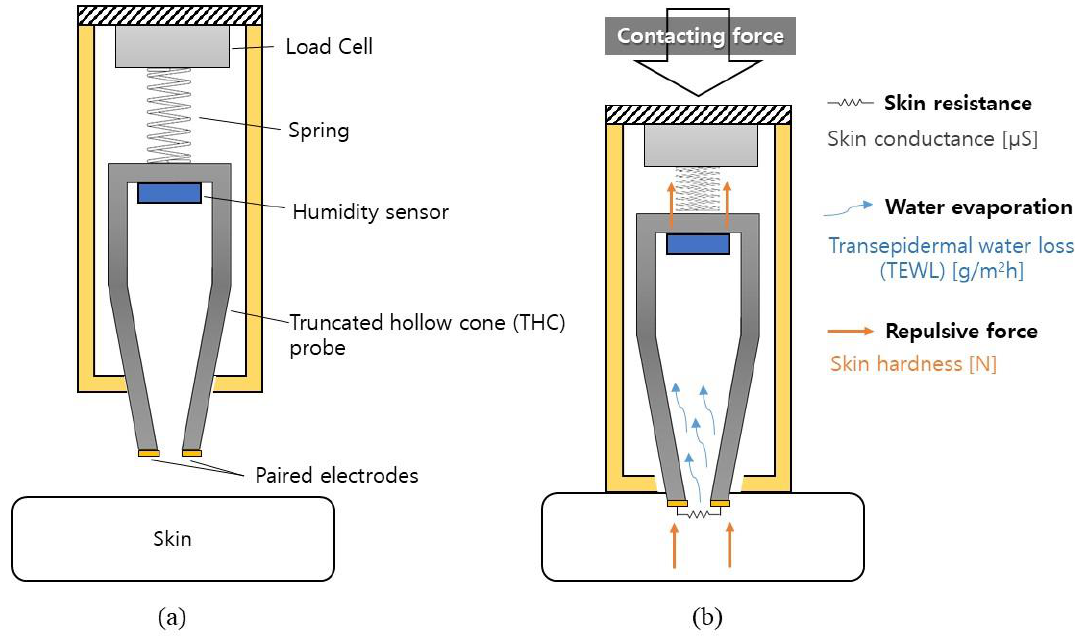
Figure 1. Working principle of the proposed device for assessing the skin conductance, transepidermal water loss (TEWL), and skin hardness, composed of a truncated cone probe, paired electrodes, a humidity sensor, a spring, and a load cell: ( a ) before skin contact; ( b ) after skin